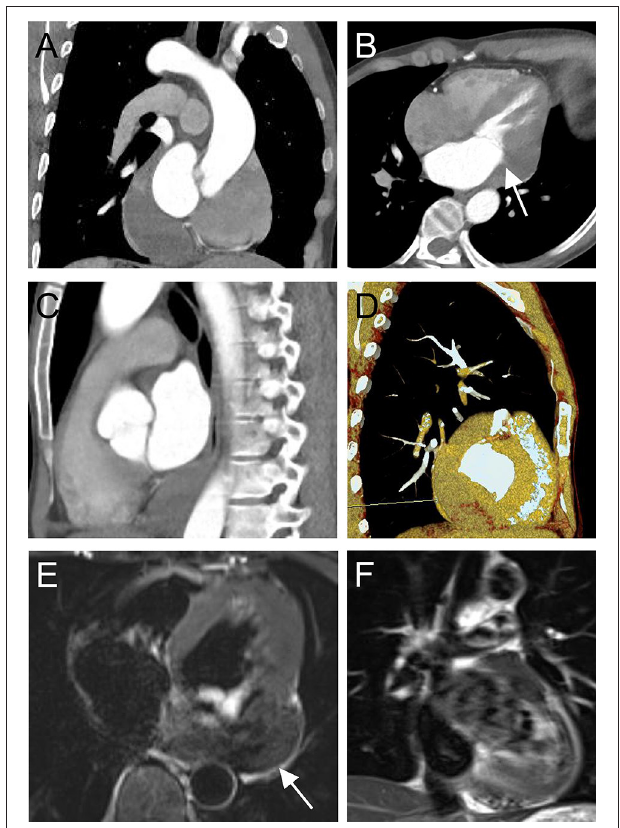
FIGURE 2 | Computed tomography pre-operatively in coronal view (A) , four-chamber view (B) , sagittal view (C) , three-dimensional volume-rendered image, and (D) shows a tumor-like structure located in the left atrioventricular groove (arrow) with a fountain sign from the posterior wall of the left atrium to the abnormal mass. Cardiac magnetic resonance imaging (E,F) pre-operatively showing a heterogeneous mass with the posterior wall of the left ventricle